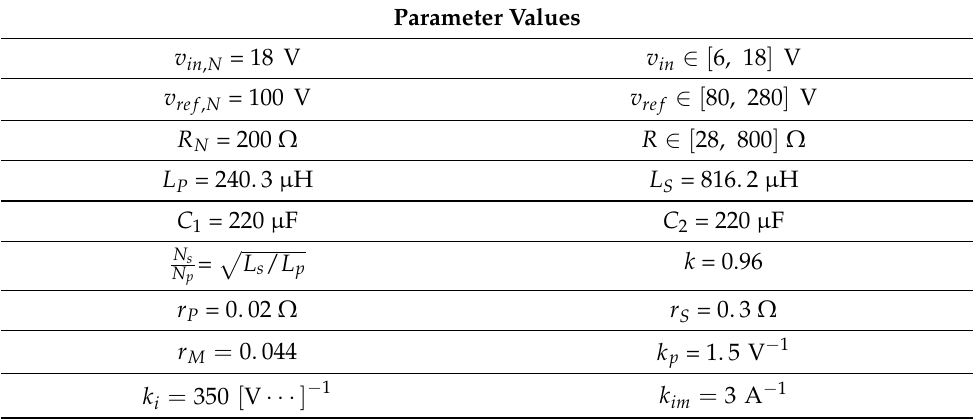
Table 2. The parameter values used in simulation. v ref , v in , and R are used for bifurcation diagrams and simulating disturbances. Unless otherwise stated, the nominal values v in , N , v ref , N , and R N are